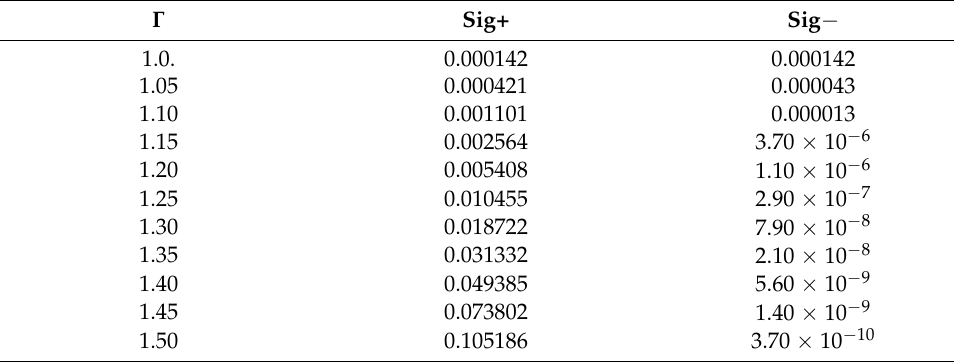
Table 6. Rosenbaum bound analysis for grain